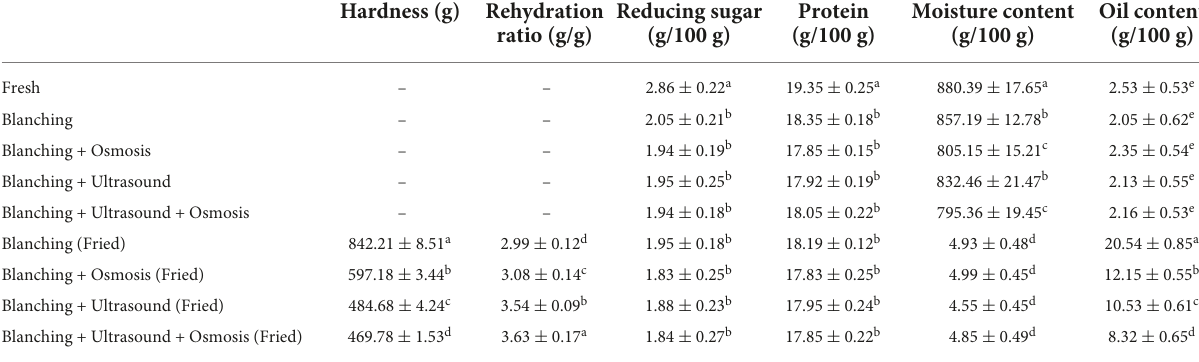
TABLE 1 Quality analysis of Pleurotus eryngii